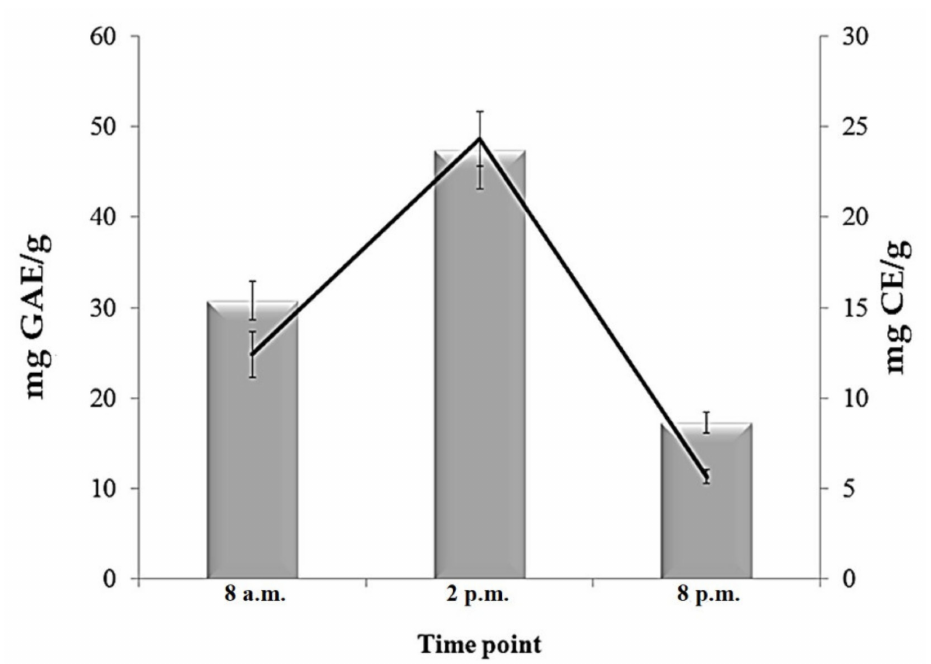
Figure 5. Total phenolics and total flavonoids contents in Plectranthus amboinicus leaf essential oil extracts (expressed as gallic acid equivalent (GAE) and catechin (CE)